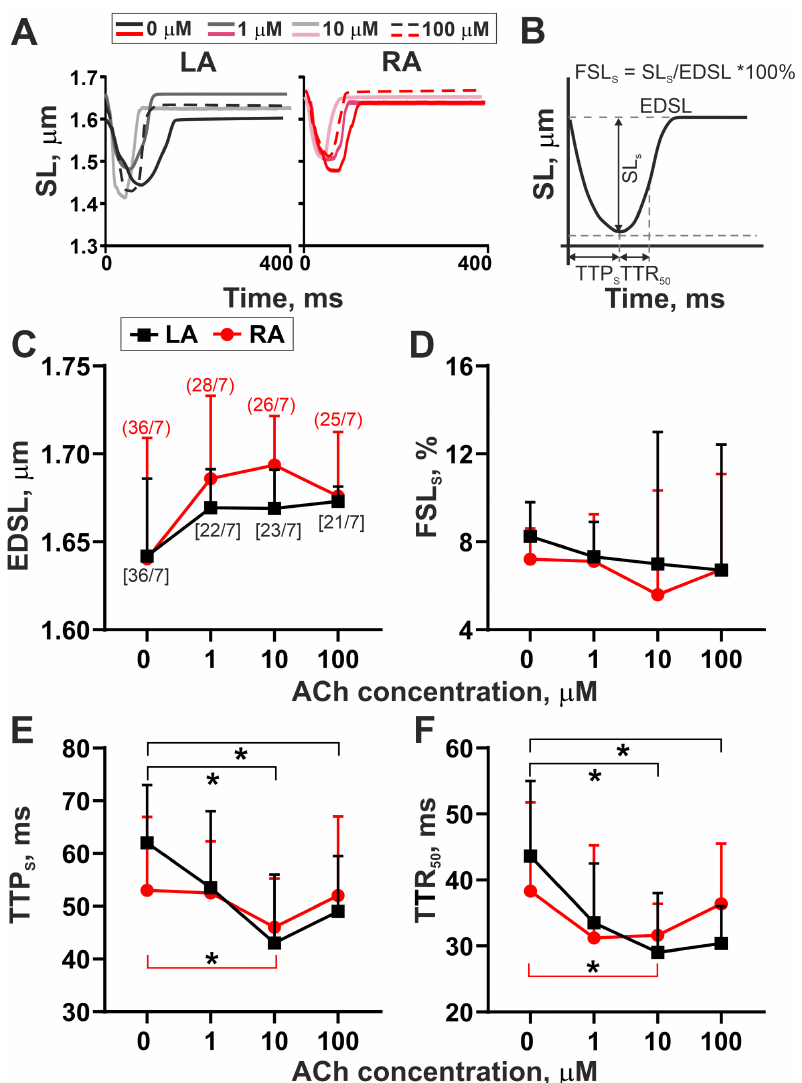
Figure 1. Dose–response curves of the amplitude and time course parameters of sarcomere shortening–relengthening in single mechanically non-loaded LA and RA cardiomyocytes to 1–100 µ M ACh. ( A ) Representative recordings of time-dependent sarcomere length (SL) changes in LA and RA cardiomyocytes from the control group (0 µ M) and after incubation with ACh for 10–15 min. ( B ). Analyzed parameters derived from SL change signal. ( C ) End-diastolic SL (EDSL). ( D ) Fractional SL shortening amplitude (FSL S = SL S /EDSL × 100%). ( E ) Time to peak SL shortening (TTP S ). ( F ) Time from peak shortening to 50% sarcomere relengthening (TTR 50 ). The number of n cells from N hearts (n/N) is shown in square brackets (LA) or parentheses (RA) in the ( C ) panel. Values are plotted as medians with interquartile ranges. * p < 0.05: 1, 10, and 100 µ M ACh compared to the control group (0 µ M ACh); one-way ANOVA (EDSL), Brown–Forsythe and Welch ANOVA tests (FSL S ), and Kruskal–Wallis test (TTP S and TTR 50